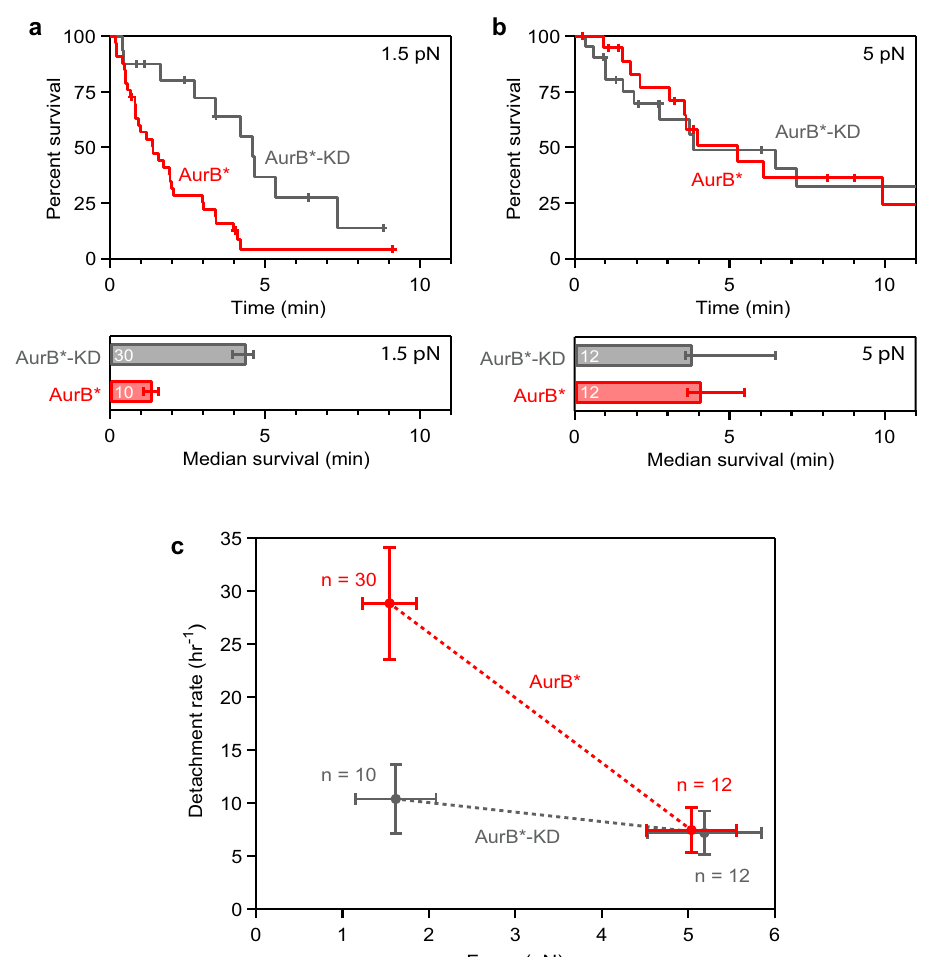
Fig. 4 Tension can suppress Aurora B-triggered detachment. a , b Kaplan – Meier survival plots (upper graphs) and median survival times (lower bar graphs) for kinetochore-microtubule attachments supporting either ∼ 1.5 pN a or ∼ 5 pN of tension ( b ) in the presence of 0.5 μ M AurB* or 0.5 μ M AurB*- KD. Tick marks on Kaplan – Meier plots represent censored data from interrupted events that did not end in detachment. Based on log-rank tests, p-values for the data shown in (a) and (b) are 0.0016 and 0.98, respectively (kinase-dead versus active AurB*). Median survival bar graphs show times at which the Kaplan-Meier survival probability falls below 50%. Error bars represent interquartile range, estimated by bootstrapping. Values inside bars indicate numbers of detachment events for each condition. ( c ) Overall detachment rates for kinetochore-decorated beads in the presence of 0.5 μ M AurB* or 0.5 μ M AurB*-KD as a function of the applied force. All data for ( a – c ) were collected using a low density of kinetochores on the trapping beads (Dsn1:bead ratio, 200), using one biochemical preparation of kinetochores, one preparation of Dam1c, and one preparation of AurB*, to eliminate any possible confounding effects due to prep-to-prep variability. Vertical error bars in ( c ) represent uncertainty due to Poisson statistics, based on the numbers of detachment events observed for each condition (n-values, as indicated). Horizontal error bars in ( c ) represent standard deviation. Source data, including numbers of detachments, observation times, rate estimates, and statistical comparisons are provided as a Source Data fi le. Control data collected using kinase-dead AurB*-KD are colored in gray and data collected using active AurB* are colored in